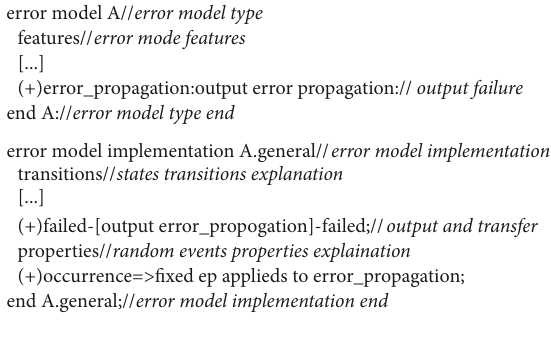
Figure 10: Error output model of component A.